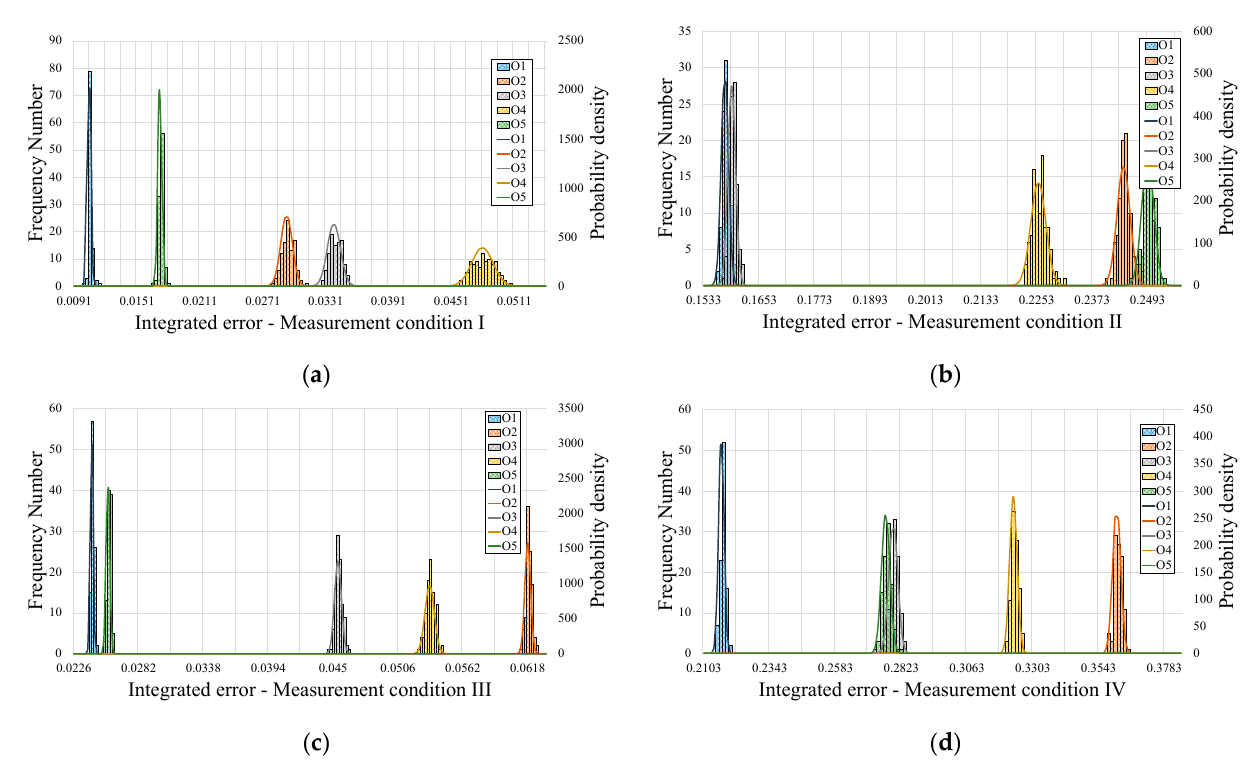
Figure 5. Histogram superimposed PDF curve of integrated error of simulations of calibration. ( a ) Measurement condition I; ( b ) Measurement condition II; ( c ) Measurement condition III; ( d ) Measurement condition IV.